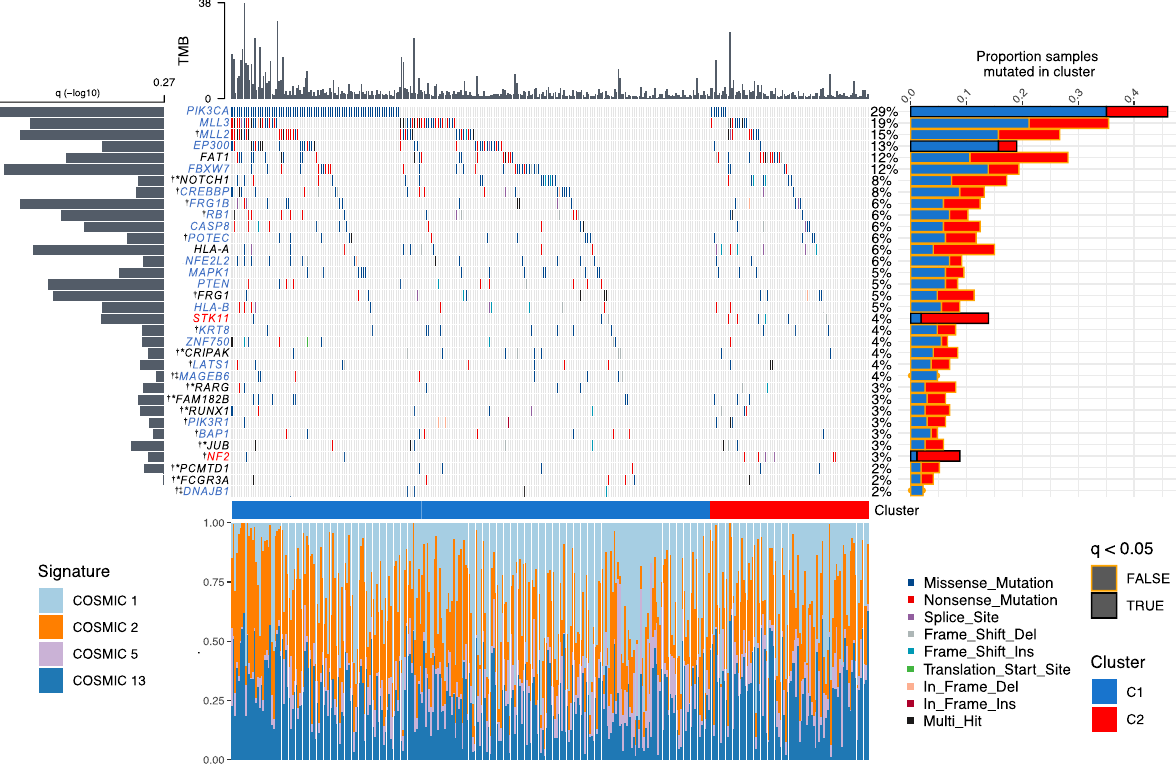
outlines around bars in this histogram signify a signi fi cant difference (FDR<0.05, Wald Test) in mutation frequency between clusters. The stacked histogram below themainplotrepresentsthebreakdownof single basemutationalsignatures(SBS) detected in each tumour. Gene name key: blue=SMG in C1 tumours; red=SMG in C2 tumours; black=SMG in C1 and C2 tumours; black *=SMG only when com- bining C1 and C2 tumours; † =SMG not previously reported in cervical cancer; ‡ =SMG in C1 tumours but not signi fi cant when C2 tumours also